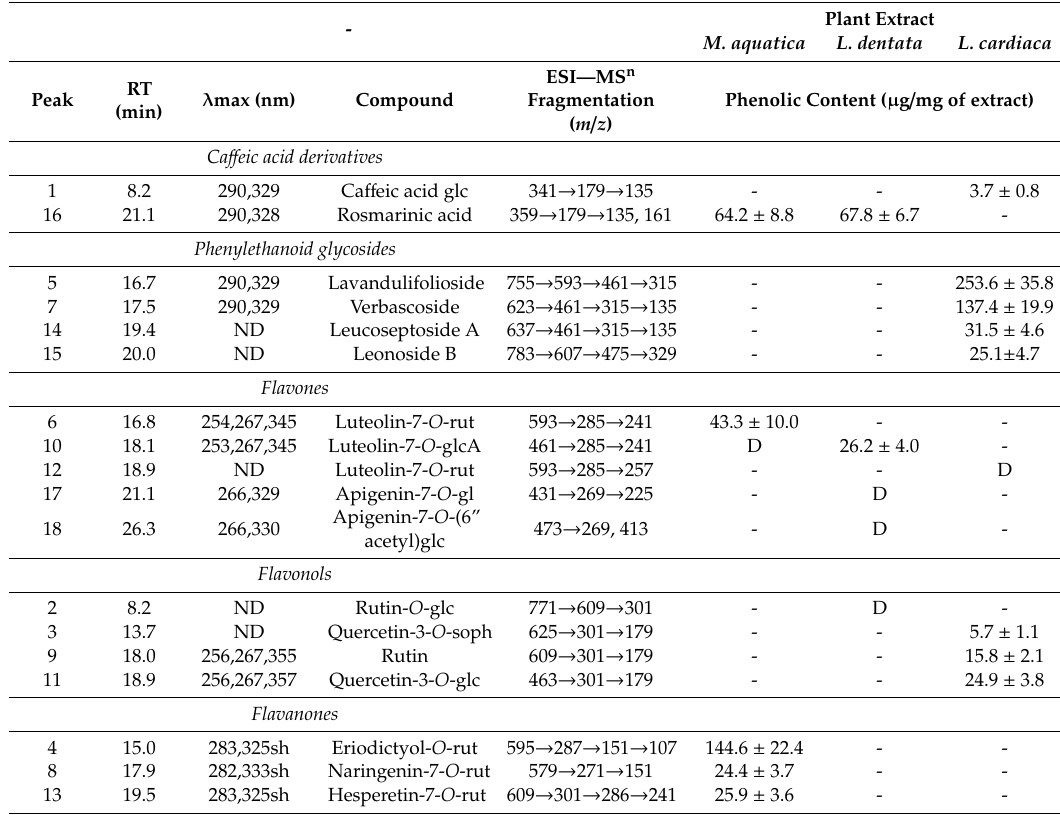
Table 2. Phenolic compounds of M. aquatica, L. dentata and L. cardiaca hydroethanolic extracts determined by UHPLC-DAD-ESI-MS n .